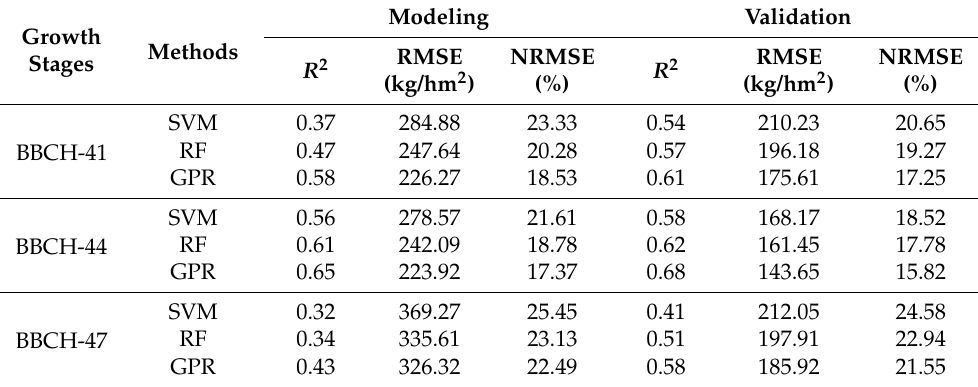
Table 5. Potato AGB estimates based on selected FDS features using machine-learning methods for different growth